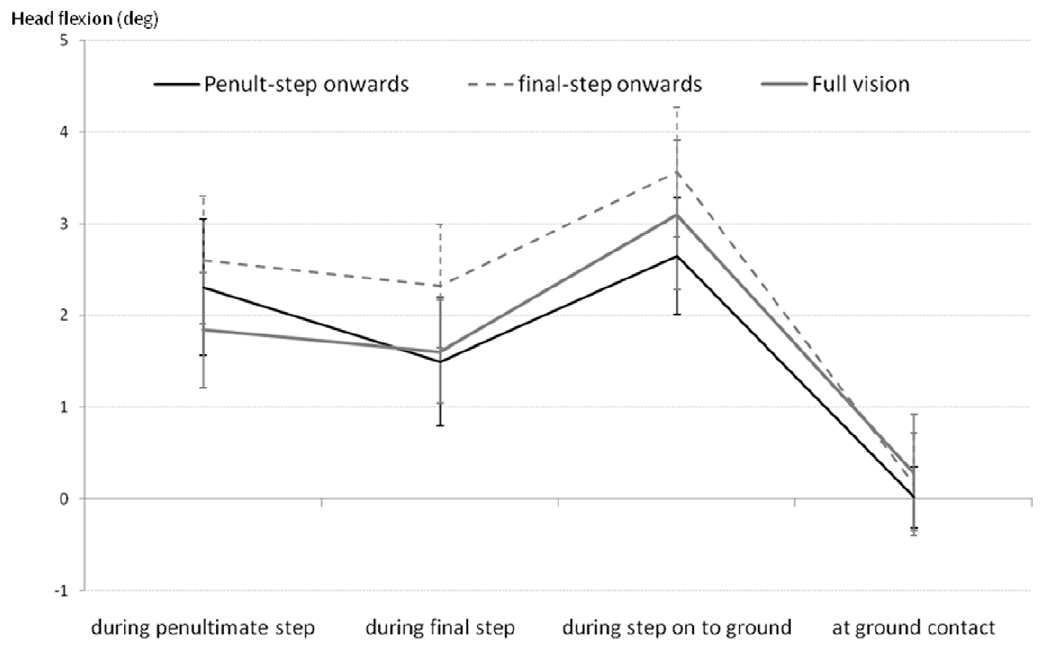
Figure 2. Group mean ( ± SE) peak amount of head-flexion (deg) occurring during the penultimate and final steps before the kerb- edge, step on to lower level and at instant of ground contact.